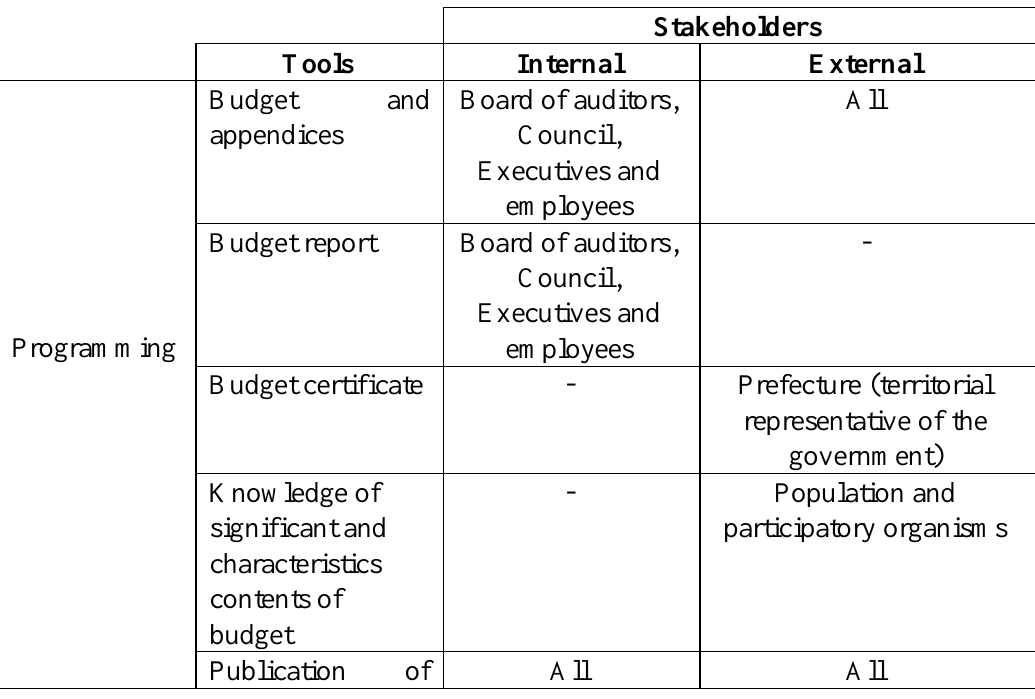
Table 3: Economic-Financial Communication Tools and Relevant